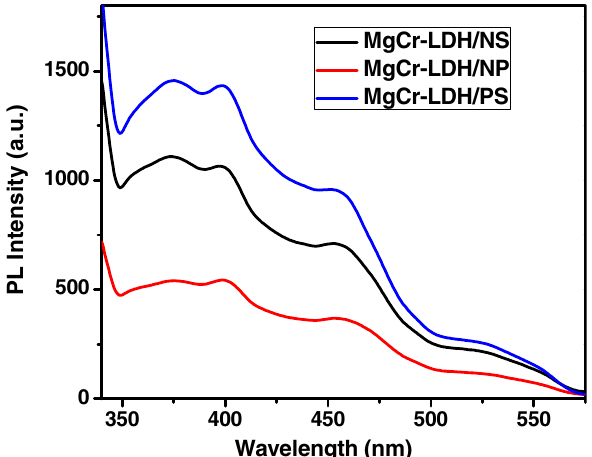
Figure 13. PL spectral plot of MgCr-LDH/PS, MgCr-LDH/NS and